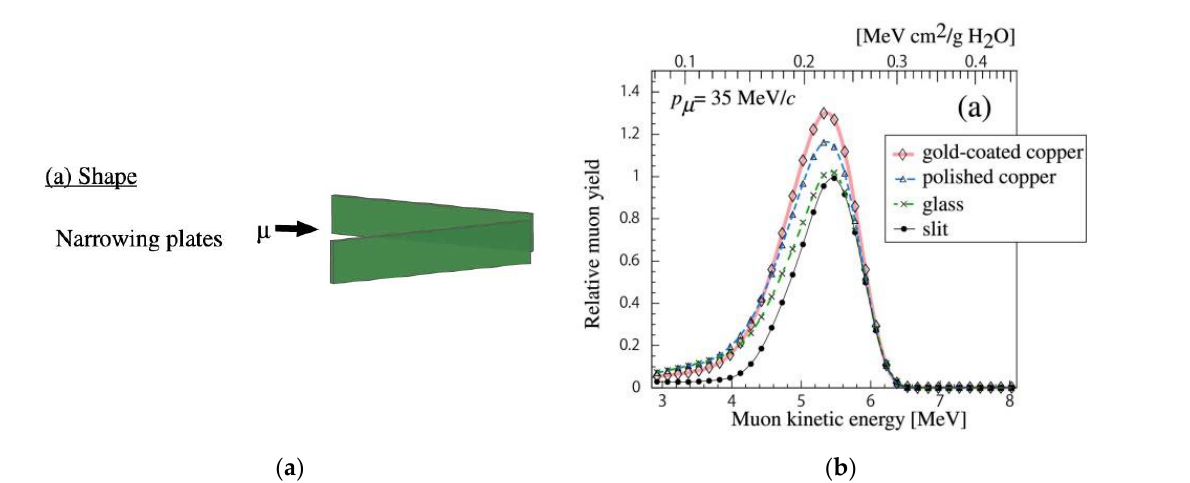
Figure 19. ( a ) Narrowing plates were used instead of a single tapered tube [61]. ( b ) Energy spectra for all plates were normalized by the spectrum for the slit. The enhancement with the gold-coated copper plates was the largest; an enhancement factor of 1.3 was obtained. (Reprinted figures from